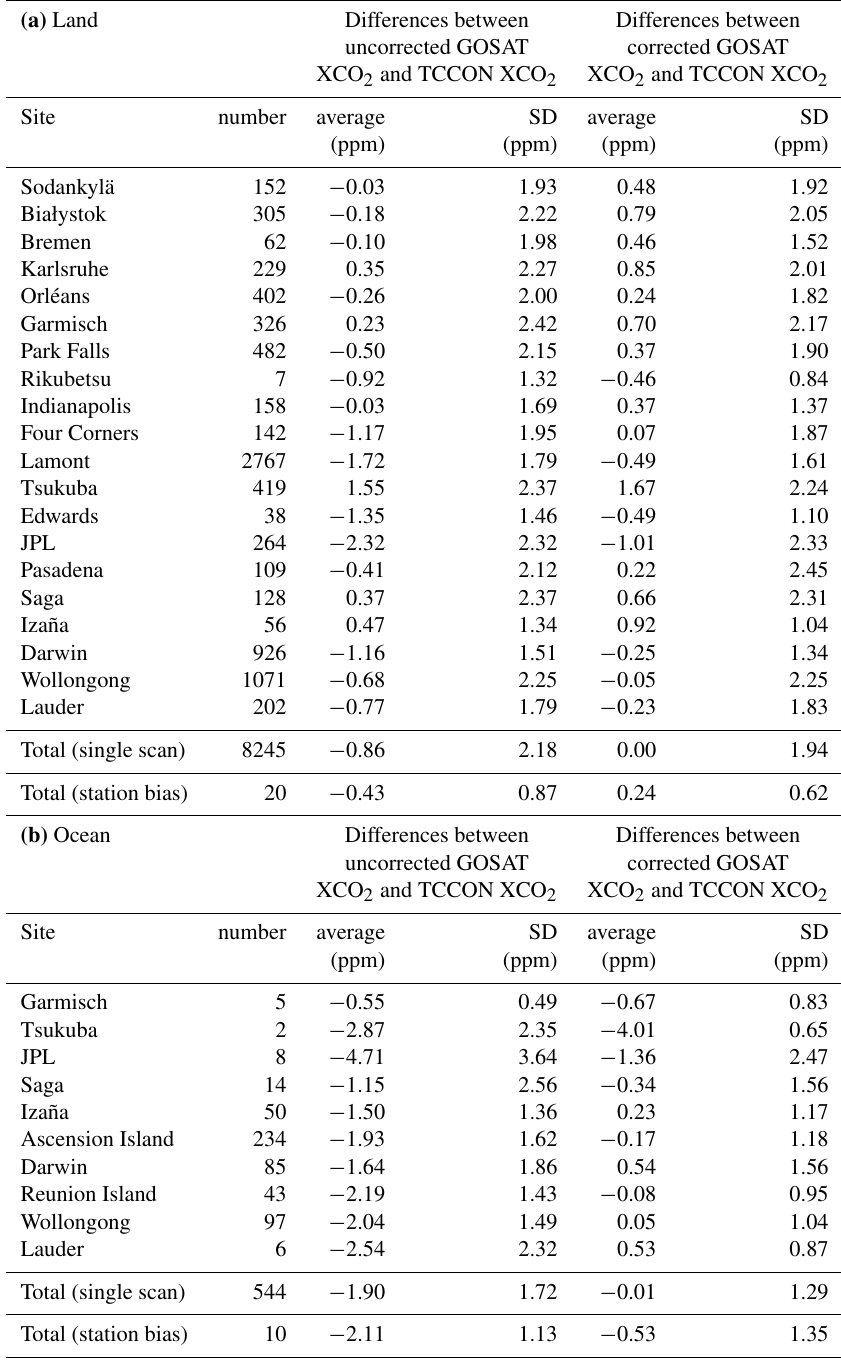
Table 4. The average and standard deviation of the differences between uncorrected/corrected GOSAT XCO 2 and TCCON XCO 2 at each TCCON site. The GOSAT data were retrieved over (a) land and (b) ocean regions within ± 5 ◦ latitude/longitude boxes centered at each site. The averages and standard deviations of the differences of the matched data at all TCCON sites (single scan) and those of the station biases are also shown in the second row from the bottom and the bottom row of the table,